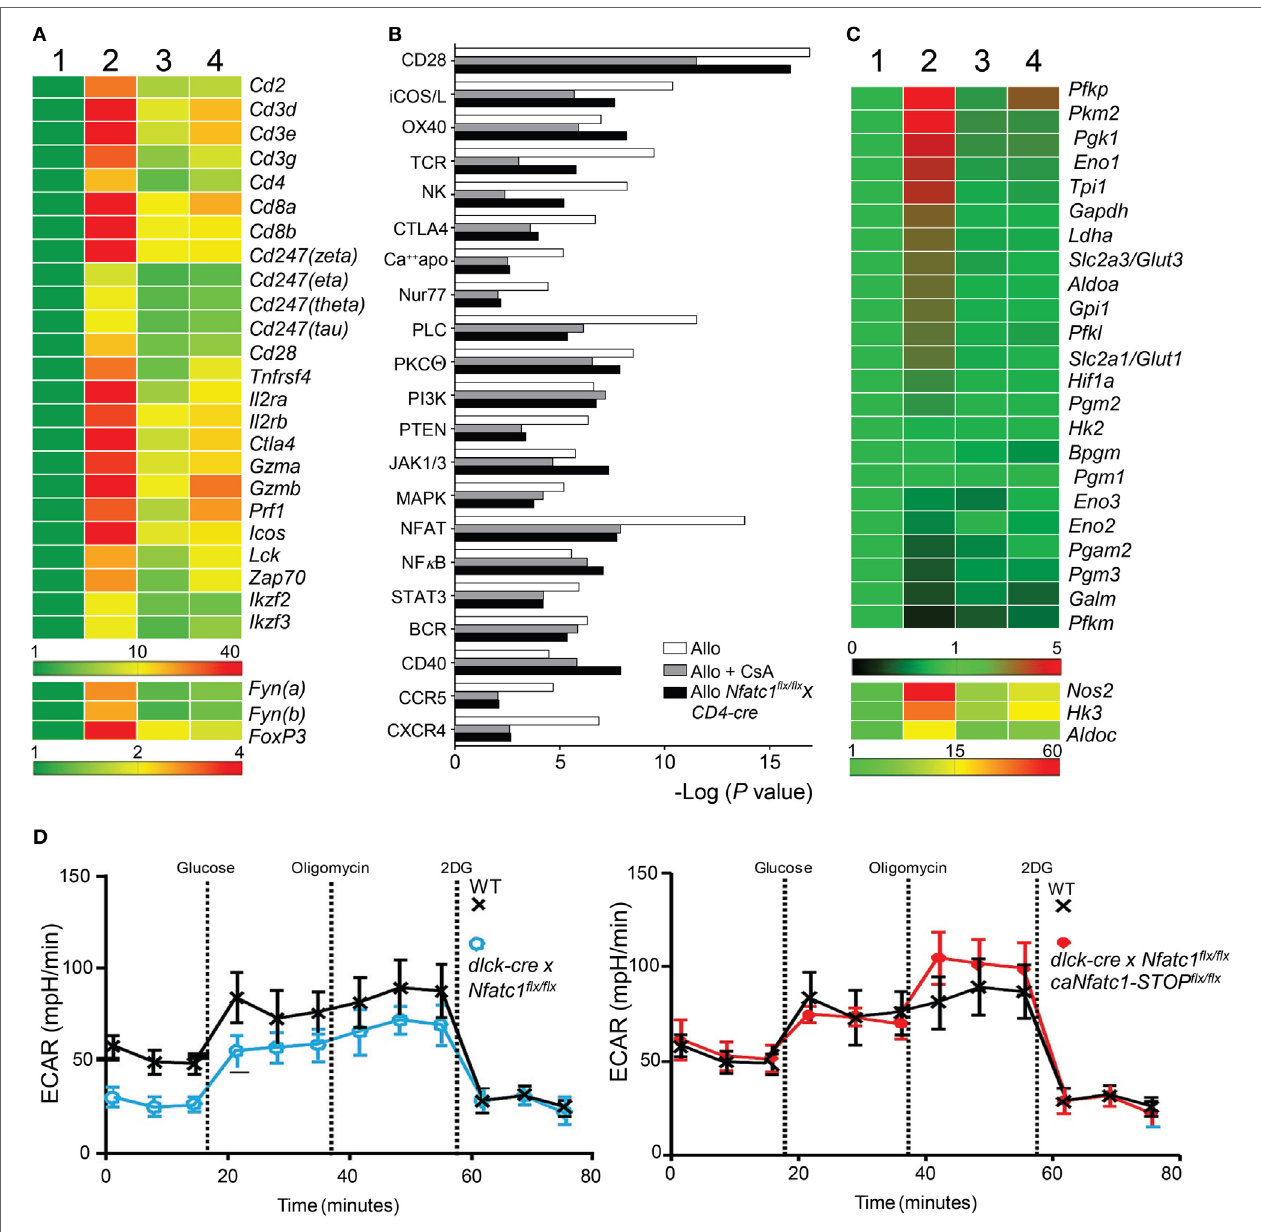
FigUre 4 | Cyclosporin A (CsA)-sensitive nuclear factors of activated T cell (NFAT) signaling is a major transcriptional pathway in Graft-Infiltrating Cells (GICs) from allogeneic heterotopic heart transplants. Syngeneic (C57BL/6, Syn) or fully allogeneic (BALB/c, Allo) heart grafts were transplanted into wild-type (WT) or NFATc1- deficient ( Nfatc1 flx/flx xCD4-cre ) C57BL/6 recipients. A subgroup of WT recipients was treated daily with CsA (15 mg/kg, Allo CsA). GICs were purified during acute rejection phase (d5) and subjected to next-generation sequencing (NGS) assays. (a) RNA expression profiles (“heat map”) of T cell signature genes. GICs were purified from syngeneic recipients (lane 1), allogeneic recipients in the absence or presence of CsA (lanes 2 and 3, respectively), and from recipients bearing Nfatc1 − / − T cells (lane 4). Their RNAs were isolated and subjected to NGS. (B) Ingenious Pathway Analyses. Expression data were normalized to the transcriptome of GICs in syngeneic transplantations. (c) RNA expression of genes encoding glycolytic enzymes. (D) Extracellular flux analyses of activated CD8 + Ts from WT and dlck-cre x Nfatc1 flx/flx mice (left), and from WT and dlck-cre x Nfatc1 flx/flx x caNfatc1-STOP flx/flx mice (right). Data of three independent assays are